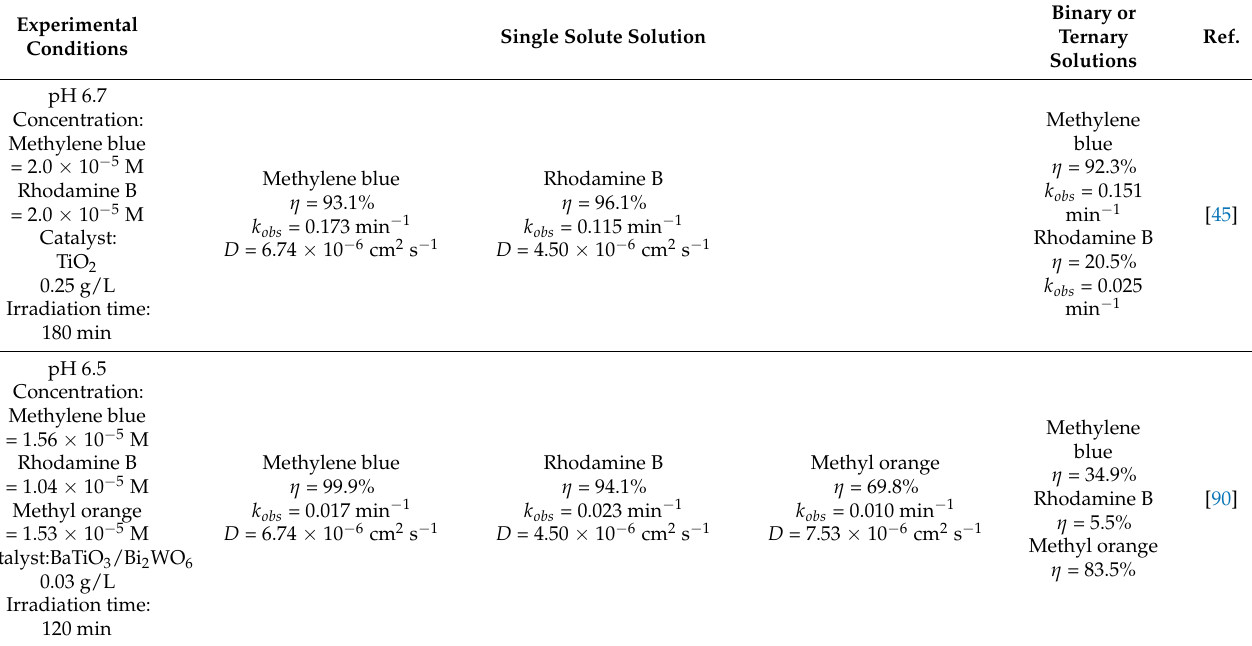
Table 1. Photocatalytic experimental conditions and observed photocatalytic degradation efficiency and rate of methylene blue, rhodamine B, and methyl orange in their single solute, binary, or ternary solutions. Single Solute Solution